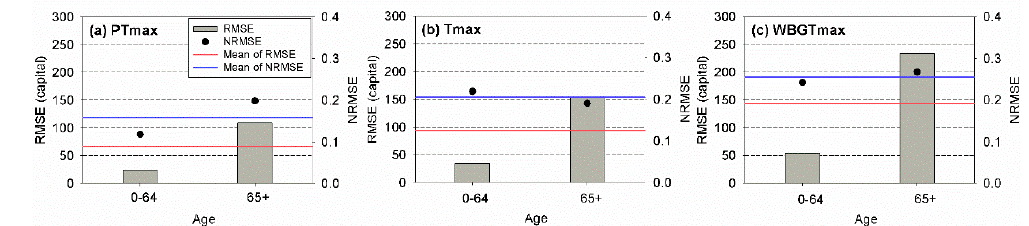
Figure 8. Root-mean-square error (RMSE) and normalized RMSE of the observed and estimated annual total mortalities for ( a ) PTmax, ( b ) Tmax, and ( c ) WBGTmax for young (0–64) and elderly (64+) people for the test period (2017–2018).